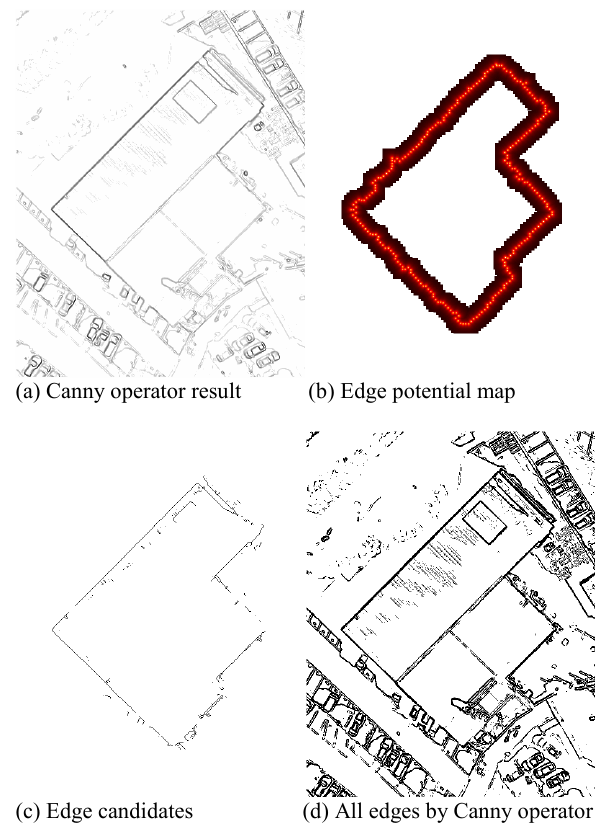
Figure 9. Edge extraction process